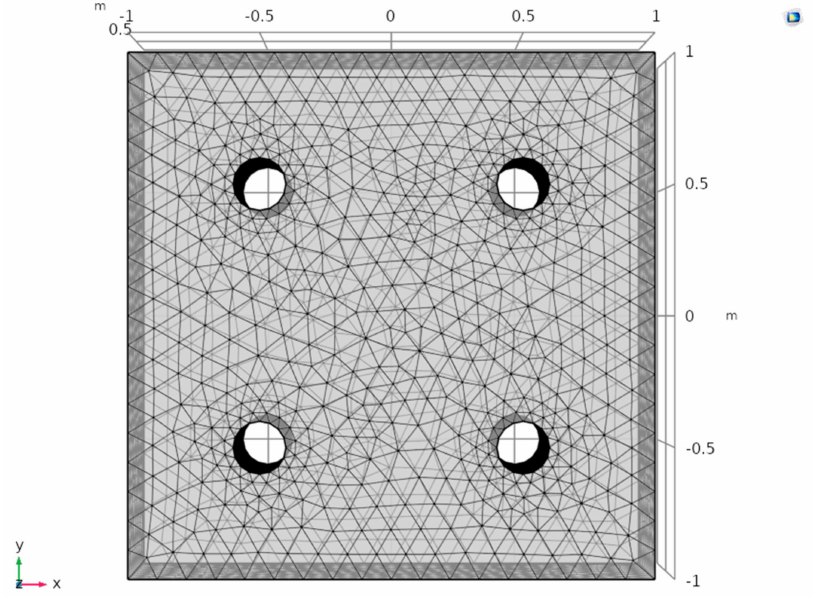
Figure 2. Grid division of the porous medium heat transfer